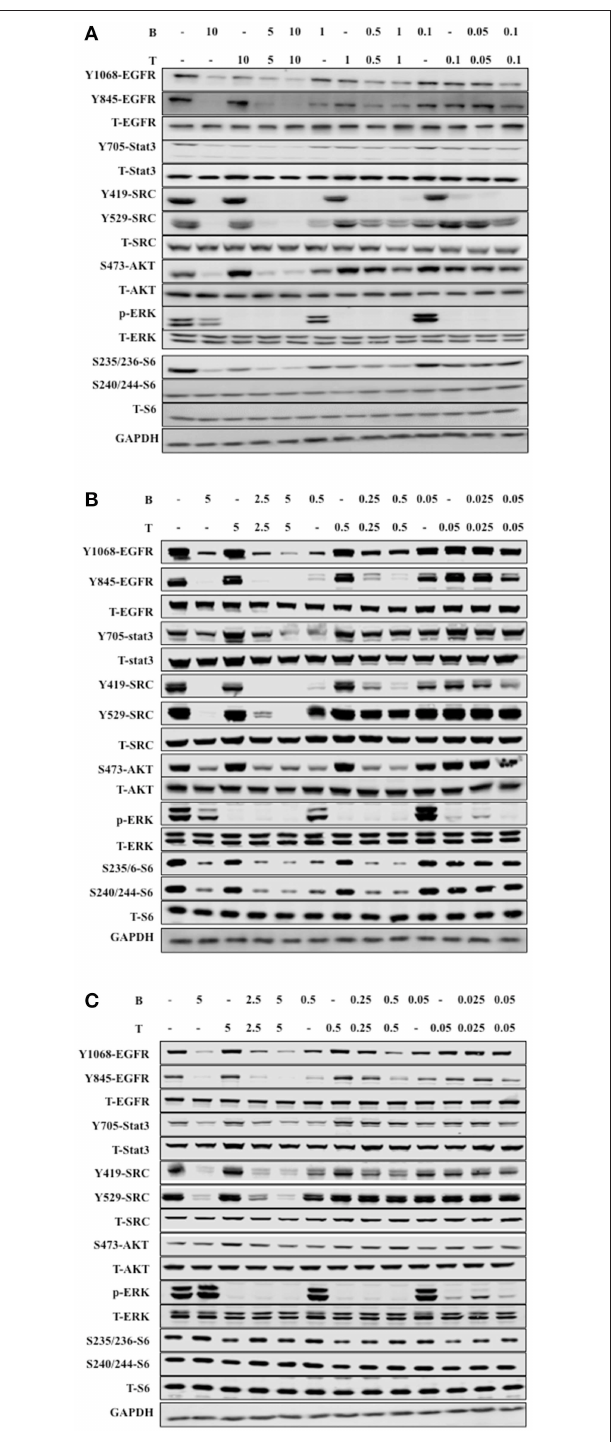
FIGURE 4 | The combination of trametinib and bosutinib enhanced anti-tumor activity through EGFR in vitro. (A) H1650 cells, (B) HCC827 cells, and (C) HCC827ER cells were treated with various concentrations of trametinib, bosutinib, or their combination for 24h. The cells were harvested, and the effects of the drugs on the protein expression levels related to the EGFR signaling pathway were detected by Western blot analysis ( n = 3 for all